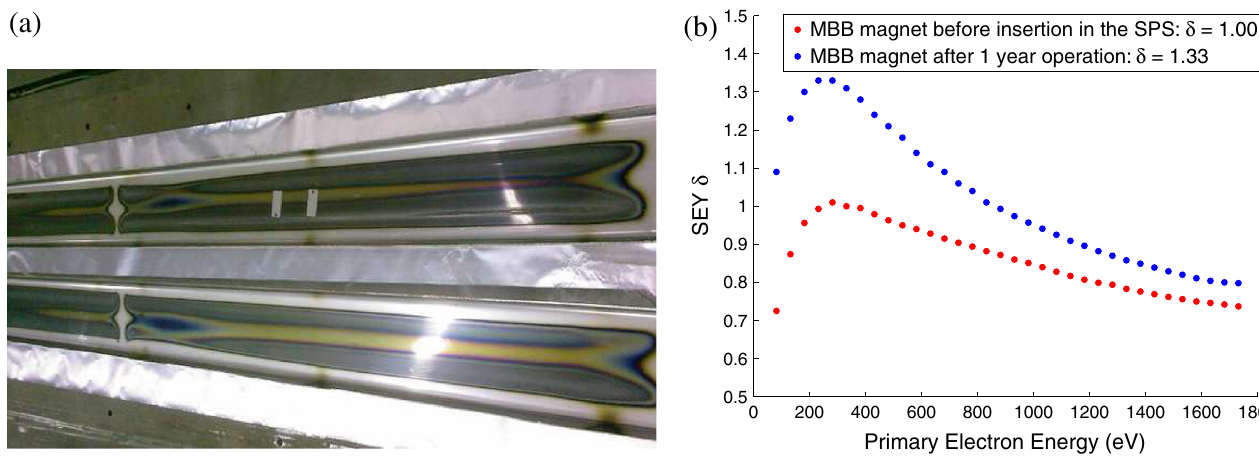
FIG. 15. (a) Inspection of the extracted a-C coated MBB after operation in the SPS. (b) SEY measurement on the coated MBB magnet beam pipe before and after operation in the